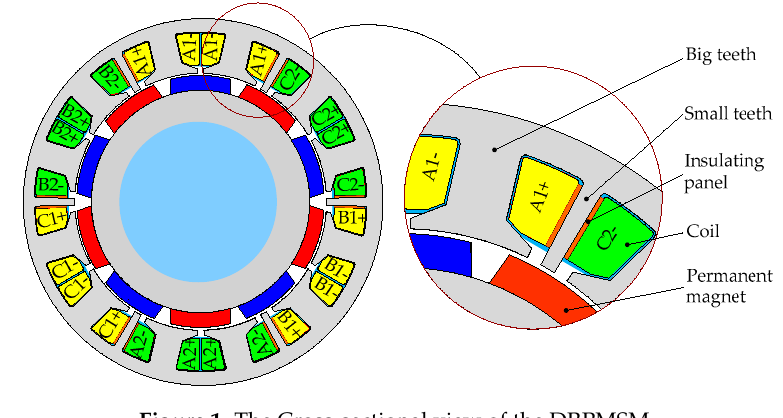
Figure 1. The Cross-sectional view of the DRPMSM.